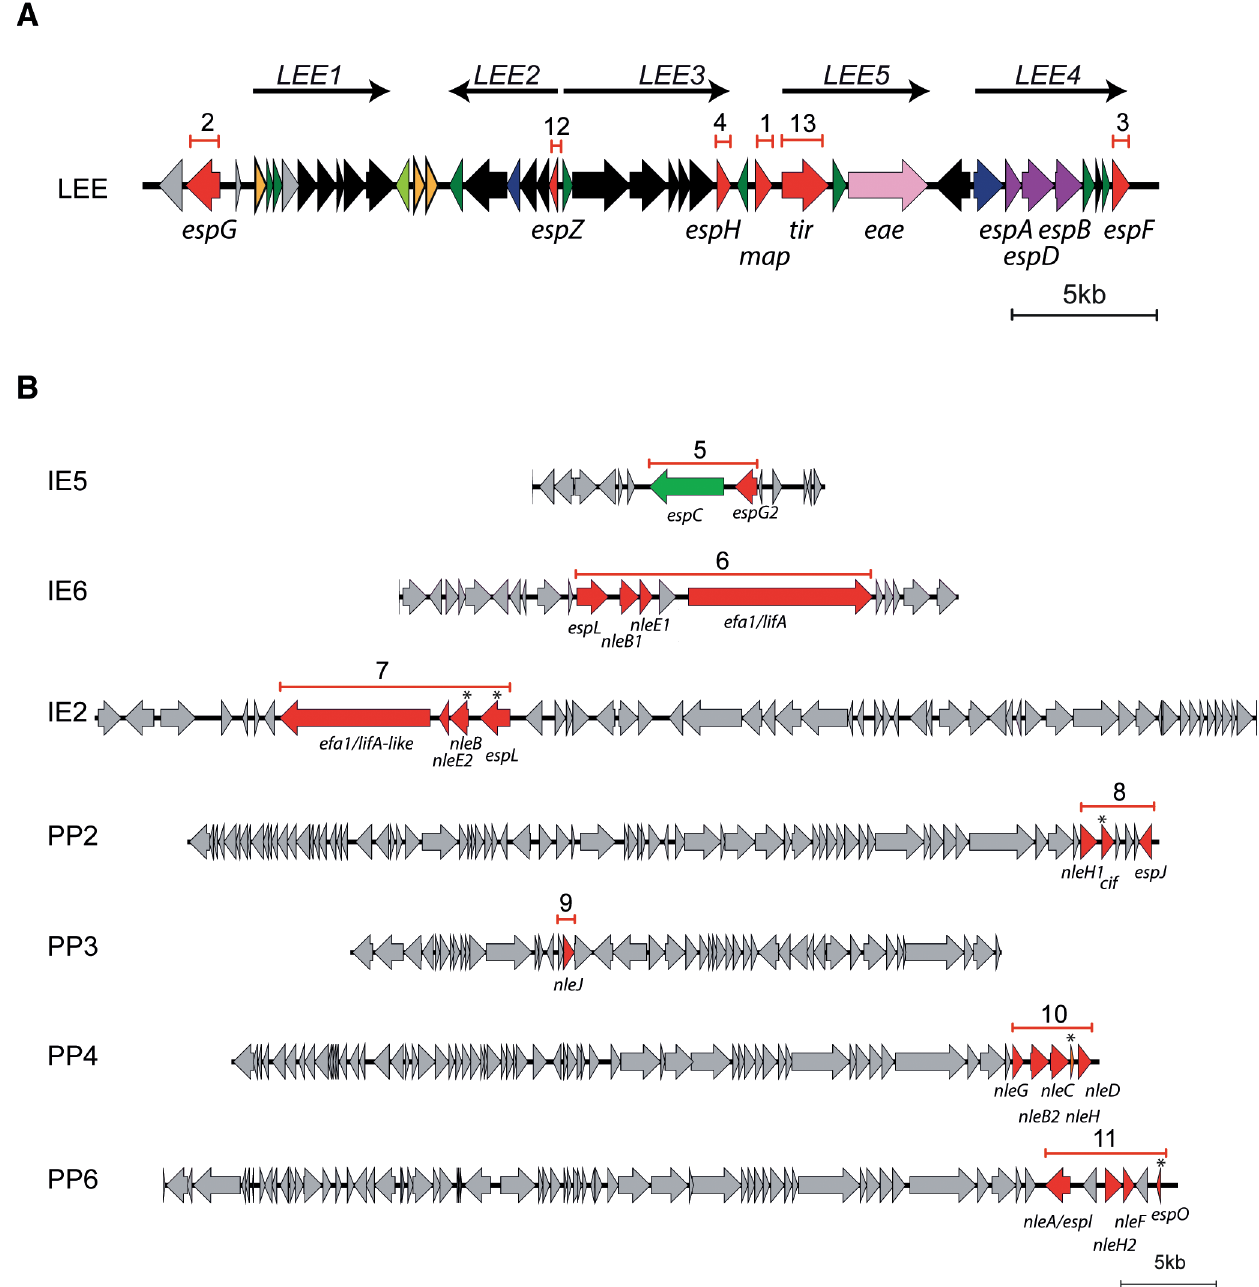
Fig 1. Deletion of effector genes in EPEC E2348/69.A . Representation of the LEE pathogenicity island. Effector genesare labeledin red. The order of deletionis numbered:deletion 1, 2, 3, 4 are for map , espG , espF and espH respectively.The espZ and tir geneswere deletedafter the non-LEEeffectors, with order 12 and 13 respectively.Scale of 5 kb is indicatedat the bottom. B . Effector genes locatedoutsidethe LEE are localizedin integrativeelements(IE) and prophages(PP). Effector genes are labeledin red. Pseudogenes are specifiedwith asterisk. The red bars indicate the deletionscarried out. The order of deletion is numbered.Scale of 5 kb is indicatedat the